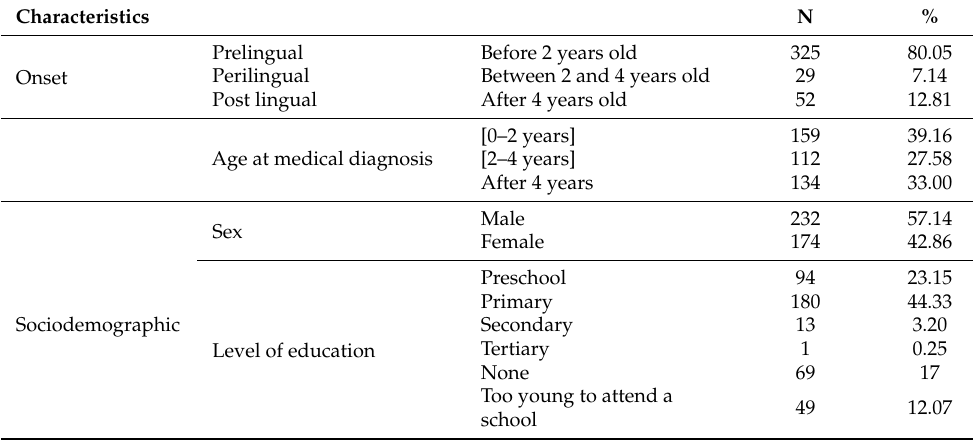
Table 1. Participants’ Sociodemographic and Onset of Hearing Impairment.